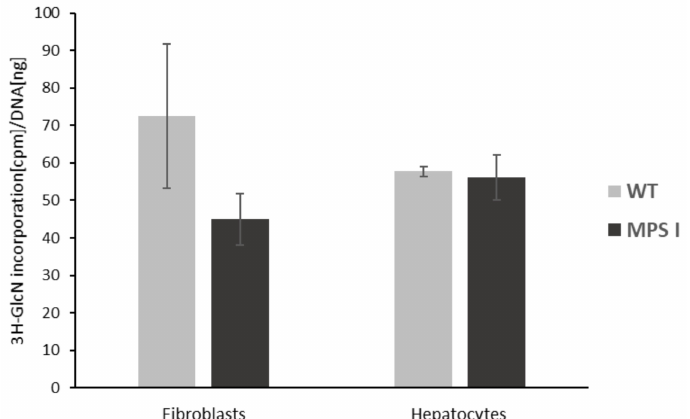
Figure 3. Kinetics of glycosaminoglycans (GAG) synthesis in murine fibroblasts and primary hepato- cytes. The incorporation of radioactively labelled glucosamine (3H-GlcN) into GAGs was measured after 24 h of culture in a scintillation counter and calculated according to the amount of DNA. Light grey bars represent the level of GAG synthesis in wild-type (WT) cells, and dark grey bars—in mucopolysaccharidosis I (MPS I) cells. Results are presented as average values ± SD for two separate experiments and biological repeats: N = 5 for fibroblasts and N = 6 for hepatocytes. No statistical significance was detected by the t -test.